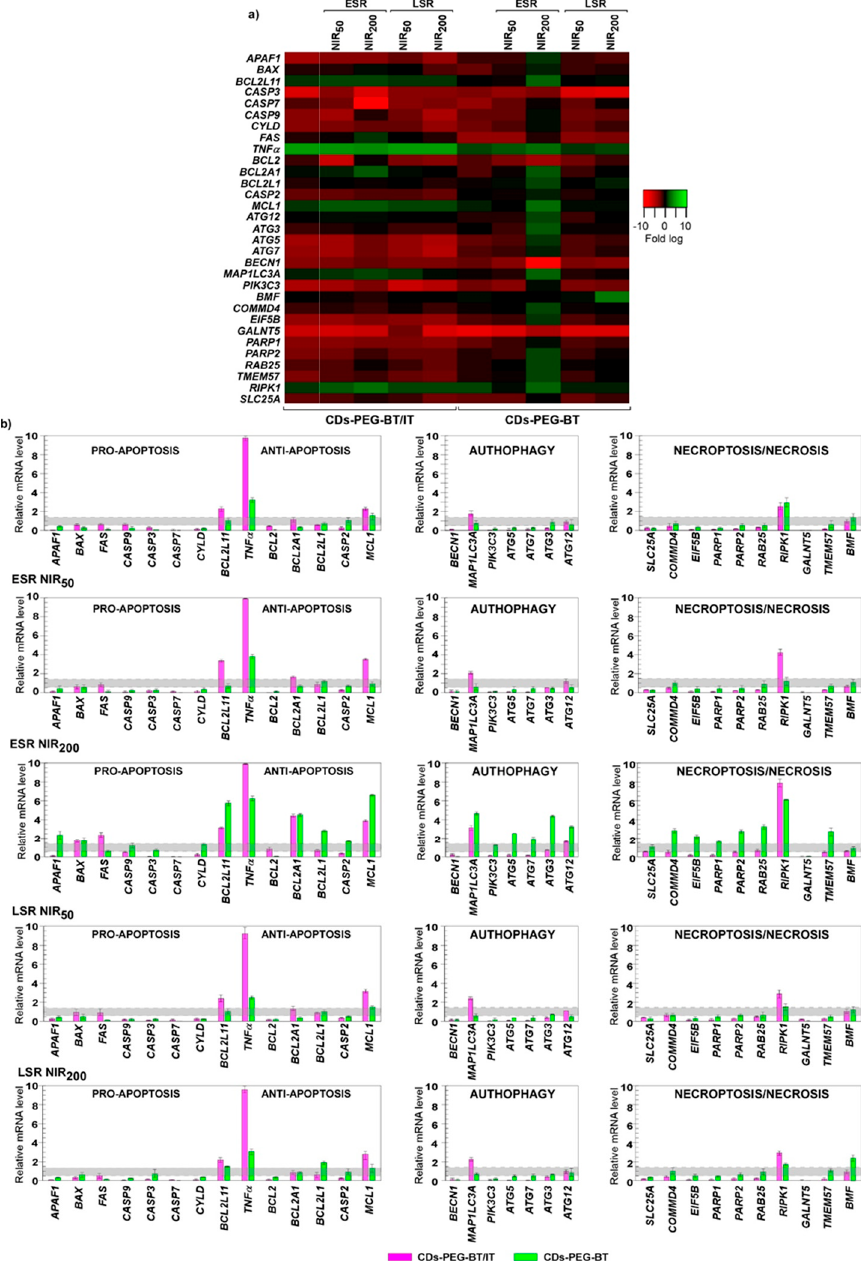
Figure 7. Cell death pathway focused gene expression analyses in MCF7. ( a ) Heat map representation of the mean-centered data of RT-qPCR results showing the mRNA levels of analyzed genes in presence of CDs-PEG-BT or CDs-PEG-BT/IT with respect to 18S , GAPDH, and ACTB . Gene expression values are colored from red (low) to green (high). Fold-changes in log (2)-transformed values are represented. ( b ) Bar plot of the pathway focused gene expression profiling. The early stage response (ESR) and long stage response (LSR) measured in response to 50 and 200 s of photothermal insults (NIR 5 , and NIR 200 ) are showed. Values beyond the gray zone were considered statistically significant at p ≤ 0.05. Statistical analyses by Student’s t -tests are reported in Table